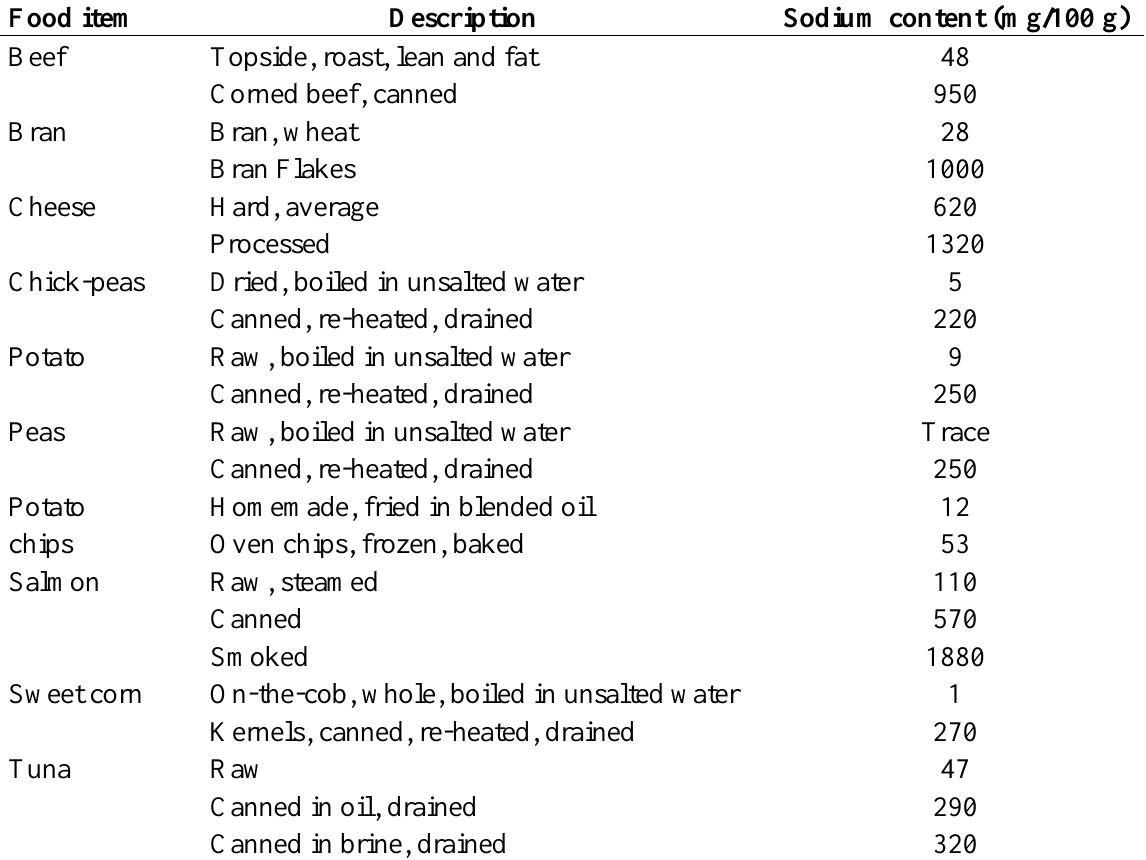
Table 1. Comparison of the sodium content of some of the ―natural‖ and processed foods